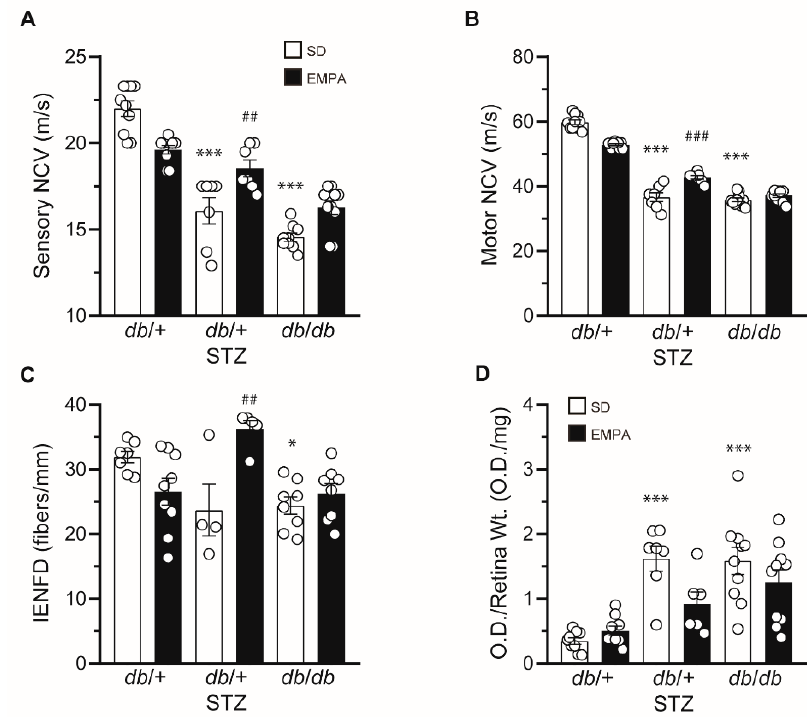
Figure 3. EMPA ameliorates neuropathy and retinopathy in T1D but not T2D mouse models. ( A – D )